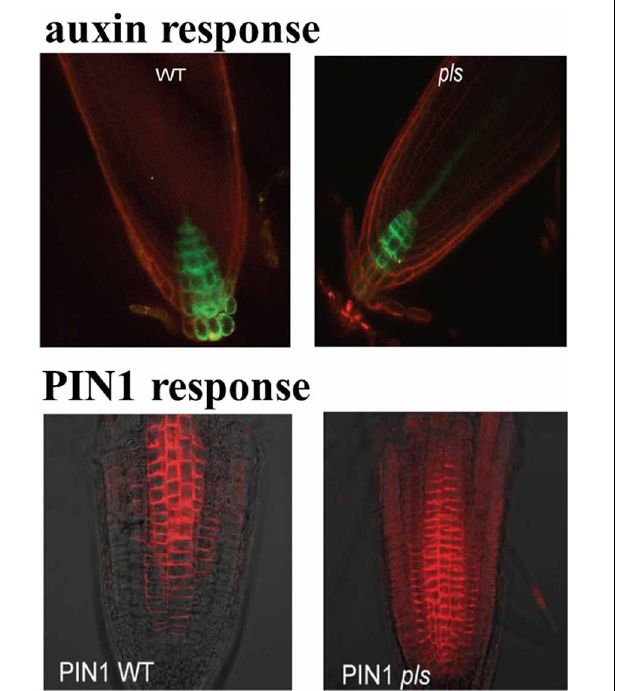
FIGURE 1 | DR5::GFP expression in wild type and pls mutant, showing difference in auxin gradients (upper panel), and PIN1 immunolocalization in wildtype and pls mutant, showing differences in PIN protein levels (lower panel). This figure is adapted with permission from the Figure 4 of Liu et al. (2010a) and the Figure 1 of Liu et al.